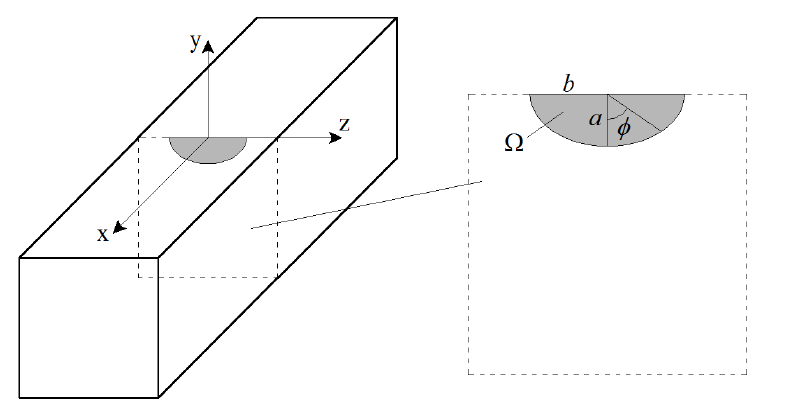
Figure 4: Crack configuration in the